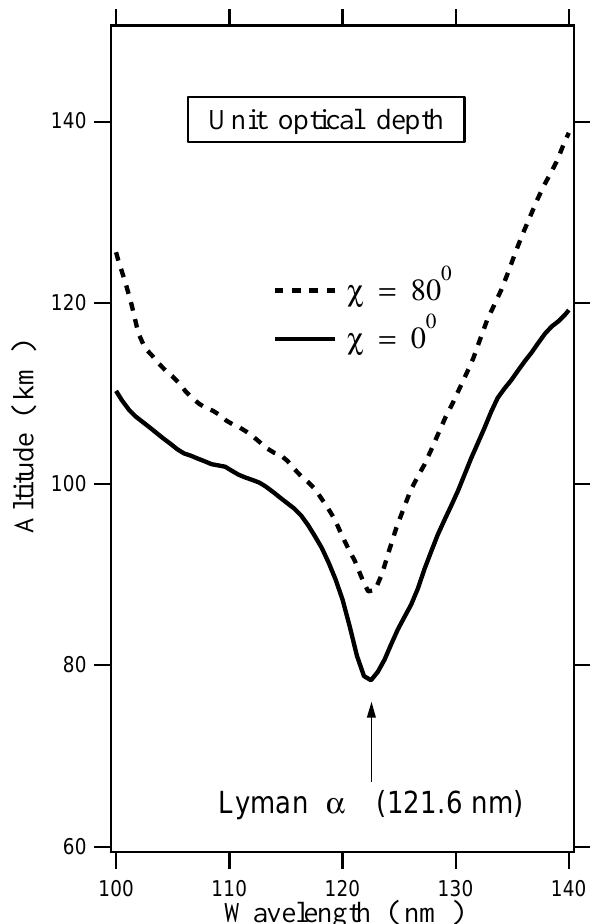
Fig. 3. Altitude where optical depth τ = 1 for solar zenith angles χ = 0 ◦ and 80 ◦